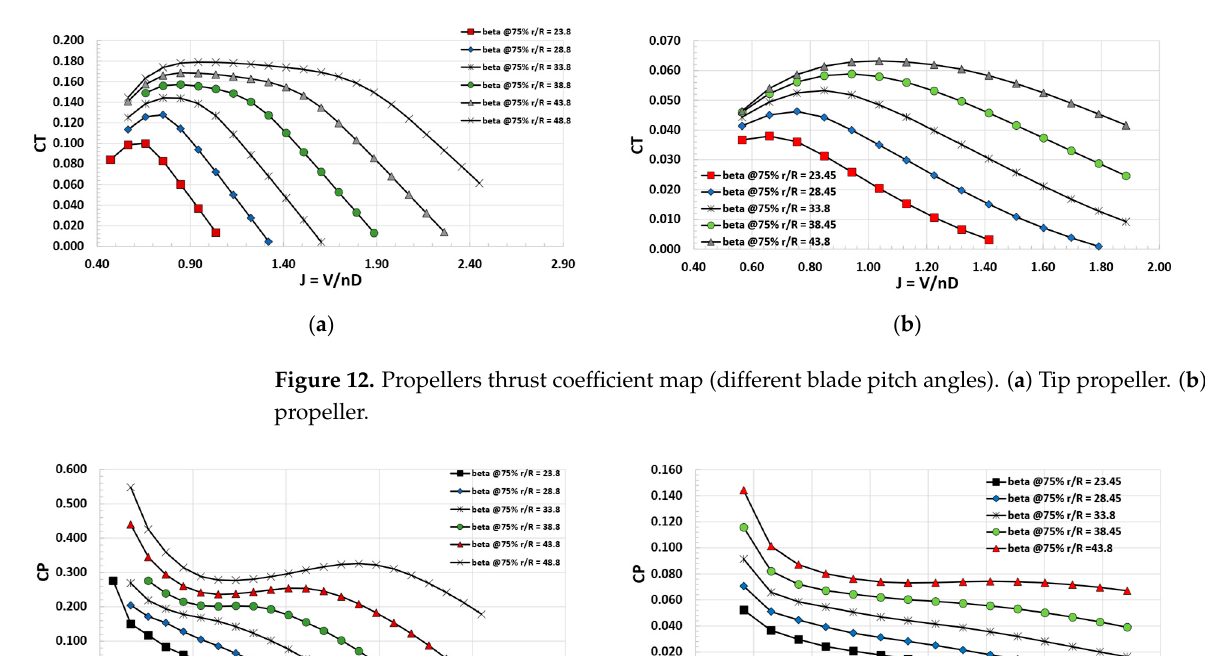
Figure 11. Propellers efficiency map (different blade pitch angles). ( a ) Tip propeller. ( b ) DEP propeller.